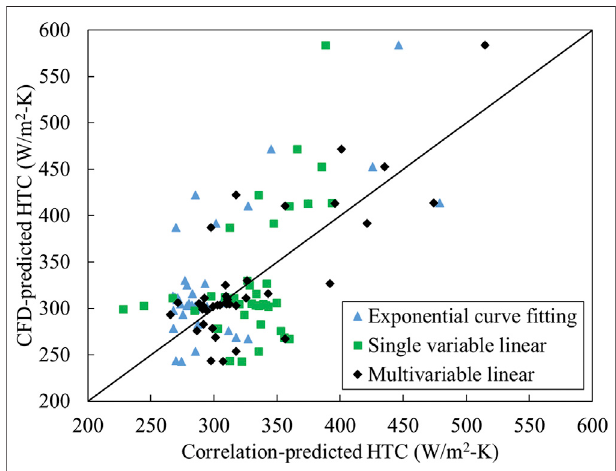
FIGURE 11 | Comparison between the CFD-predicted HTCs and the correlation-predicted HTCs.